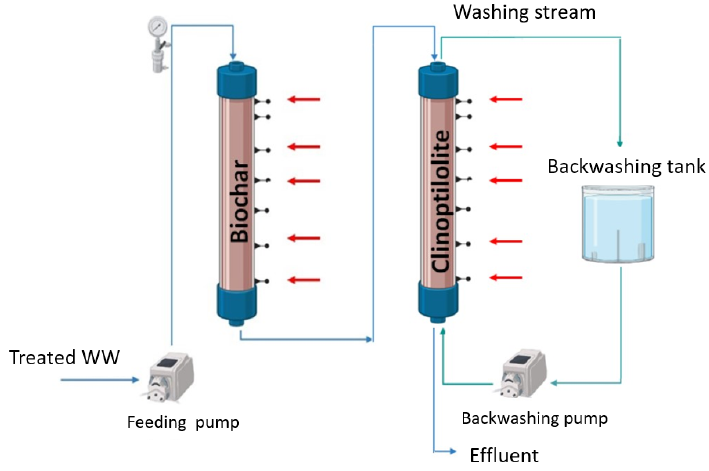
Figure 5. Nutrient recovery plant operating scheme.